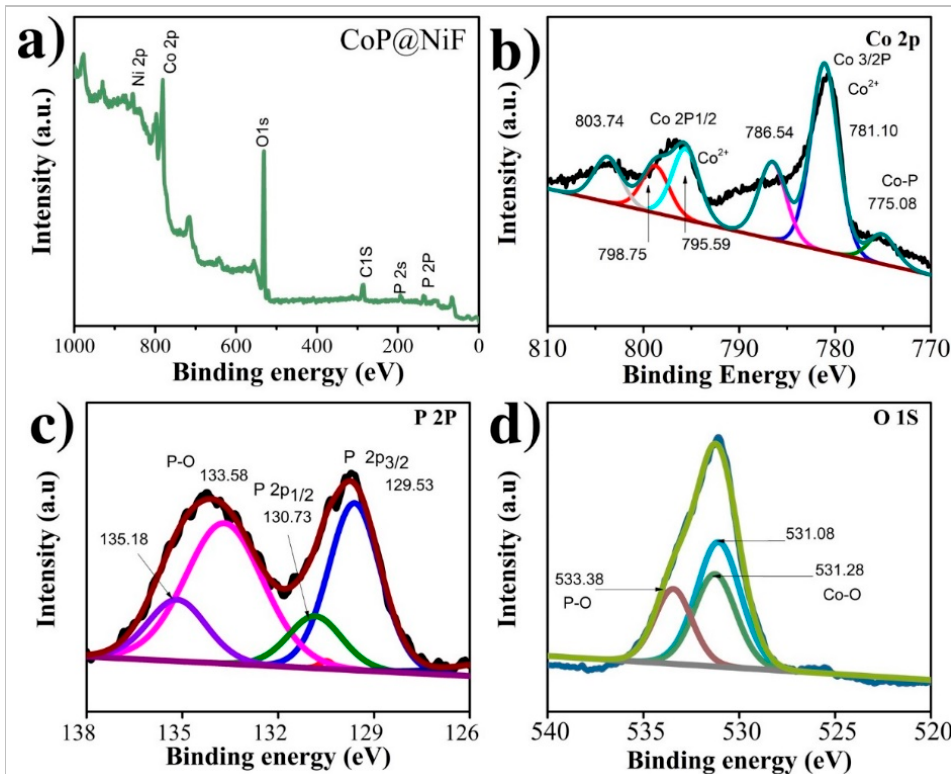
Figure 3. XPS spectra of CoP@NiF. ( a ) survey, ( b ) Co 2P, ( c ) P 2P and ( d ) O 1s.